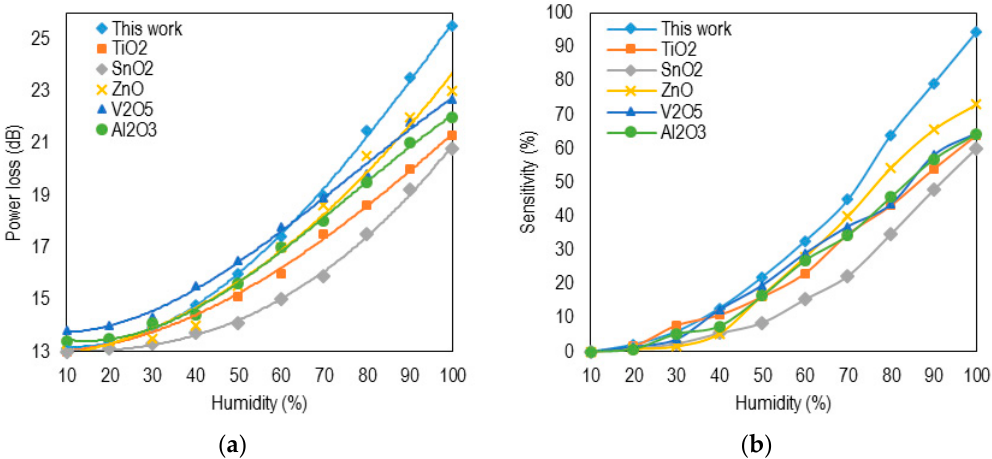
Figure 5. Profile of power loss ( a ) and sensitivity ( b ) of the proposed sensor compared to other sensors using different coating materials. There are two regions with low sensitivity in the range from 10% to 35% and high sensitivity in the range of 35% to 98%. More information regarding preparation of other materials could be found in [6].